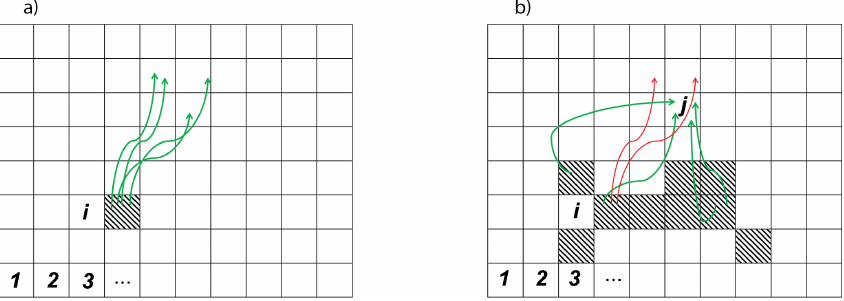
Figure 13. (a) A solution for the probability distribution of a forward case. Virtual particles are released from a box that includes the release location. Distribution of the final positions after integration time T would specify the probabilistic destination region. Calculation of the probabilistic destination region is equivalent to the solution of a Fokker–Planck equation for finding the future probability distribution of an initially known distribution. Trajectories of the released particles from the initial box are shown in green. (b) A solution for the probability distribution of a source region. For a proper forward-time integration, the starting time is shifted to t 0 − T . Virtual particles are released from all the boxes in the domain. Important particles are those that land in the target box, which includes the sampling location. Trajectories of particles that land in the target box are shown by green; other trajectories are shown by red. A solution for the probabilistic source region is conceptually the same as the solution of the backward Kolmogorov equation, where an initial probability distribution is the desired solution such that in a future time the system will have a specified probability